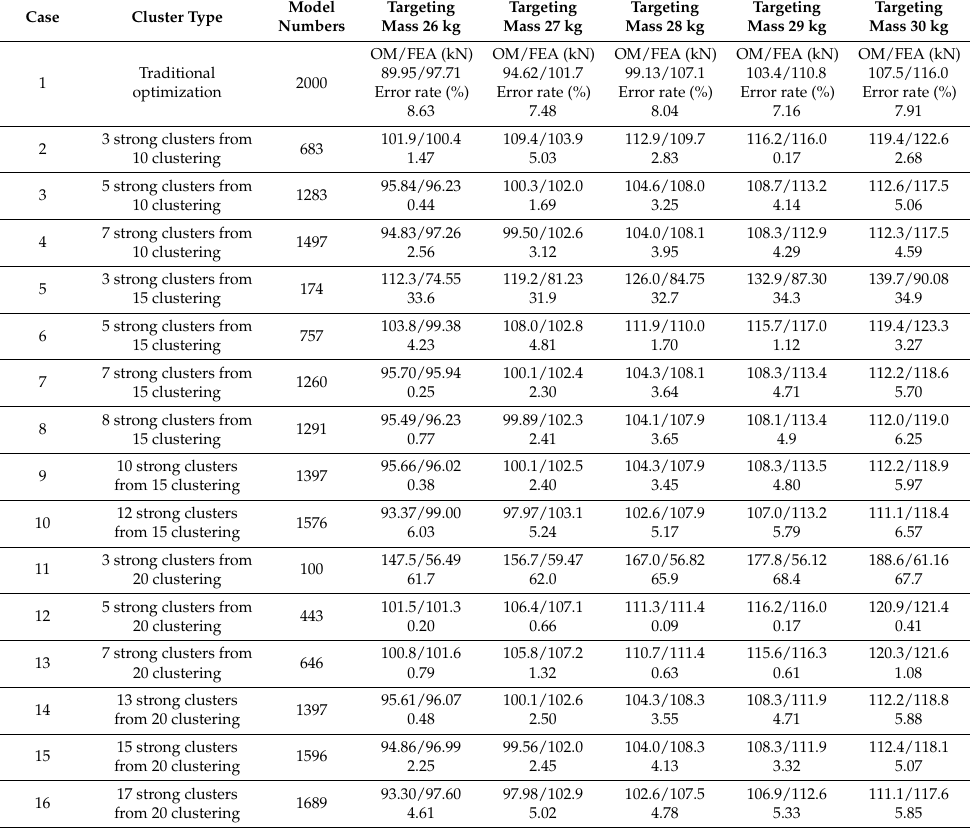
Figure 5. Improvement rate of the maximal reaction force by the proposed optimization compared with that of the traditional optimization for the three cluster types (cases 2, 6, and 13 in Table 7). Table 7. Reaction forces and error rate by the proposed optimization method (OM) in various clustering cases.